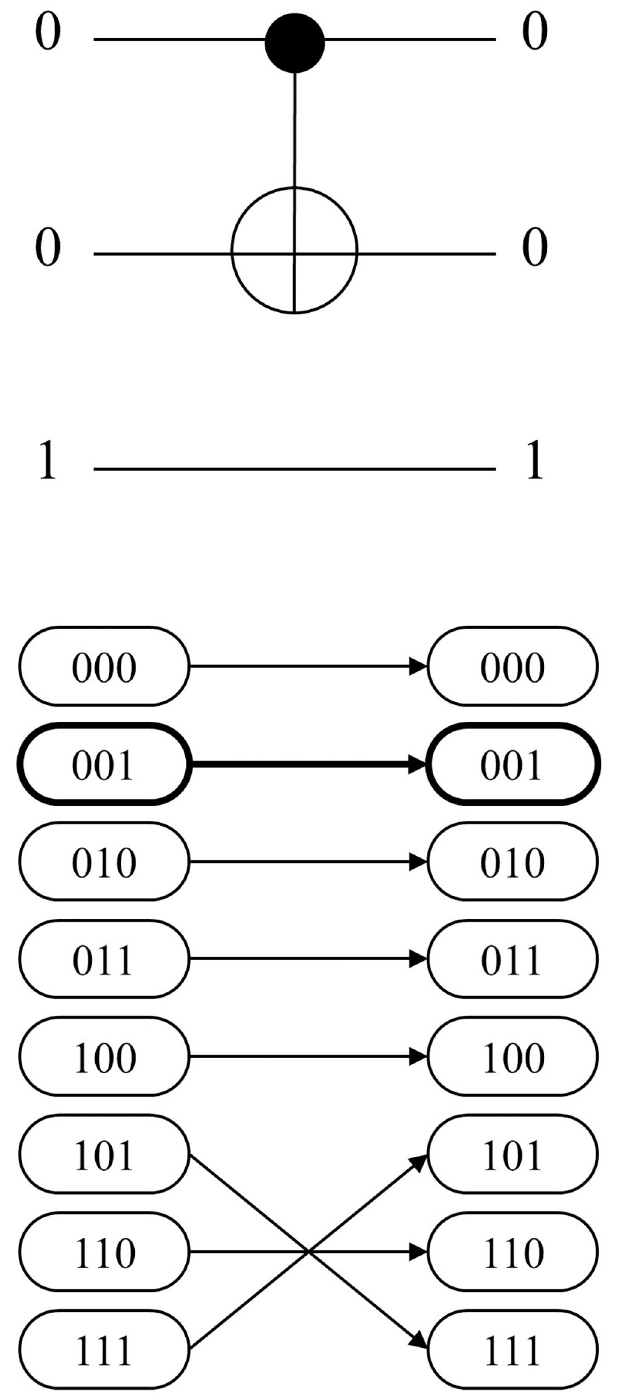
Fig 7. 3-qubit example of MCT gate-network conversion: CASE3B .